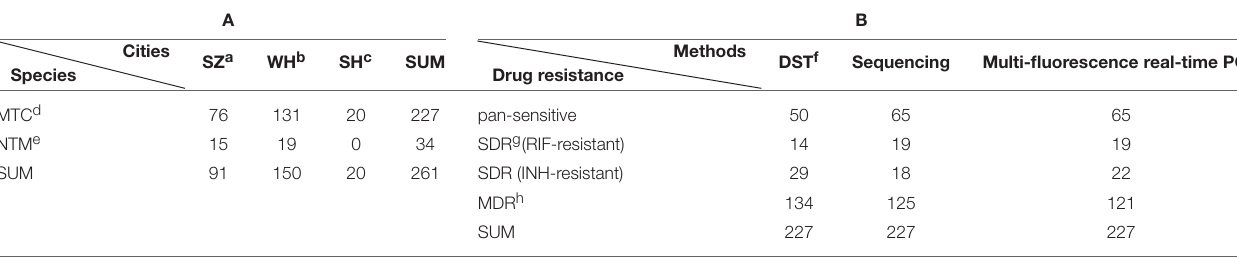
TABLE 2 | Locality, species, and drug resistance (detected by three methods) of samples in this study. A B Cities Methods SUM DST f Sequencing Multi-fluorescence real-time PCR Species Drug resistance pan-sensitive